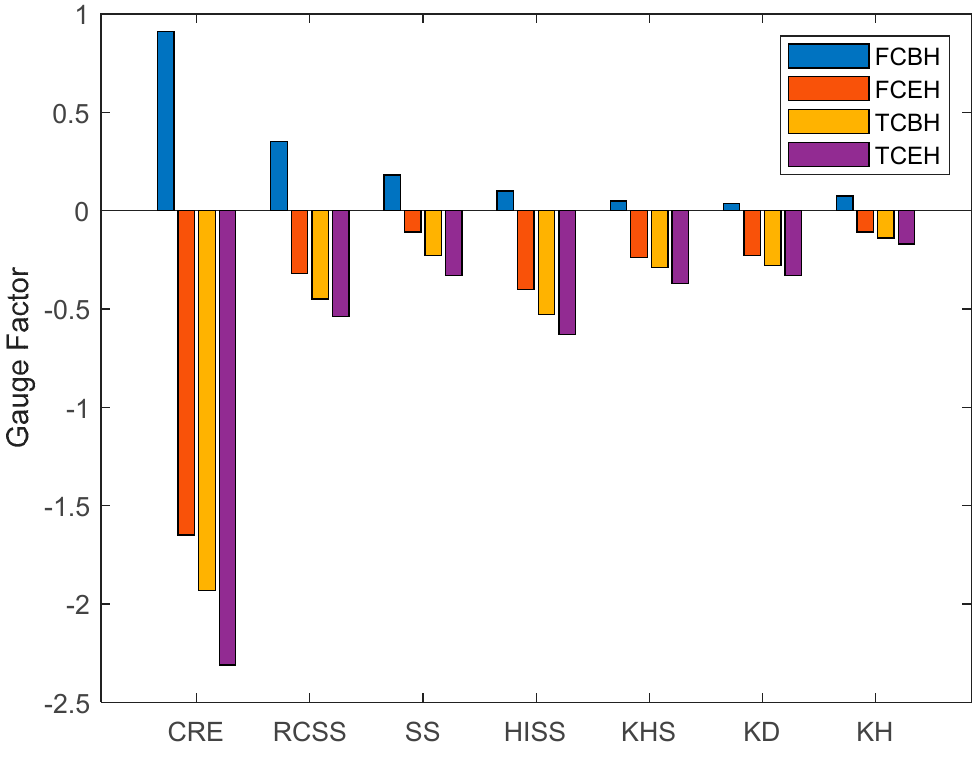
Figure 21. Gauge factor calculated using Equation (1).